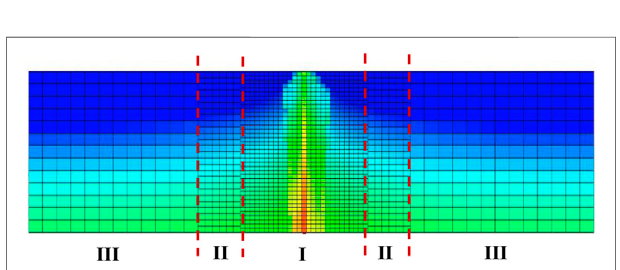
FIGURE 8 | Equivalent characterization of condensation radius by numerical simulation method (Wang et al., 2017).